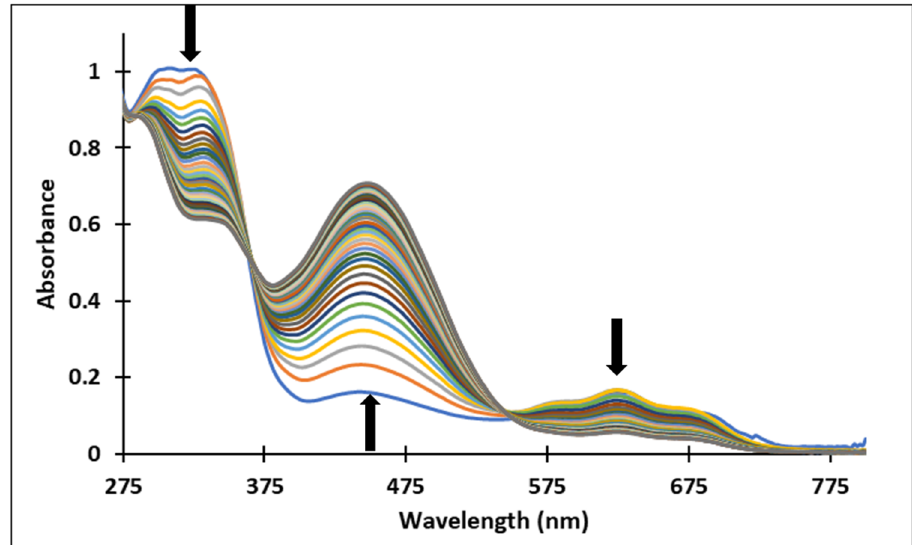
Figure 9. Spectral variations after pH-jump of a solution of compound 3 , from pH 6.09 to pH 12.16.